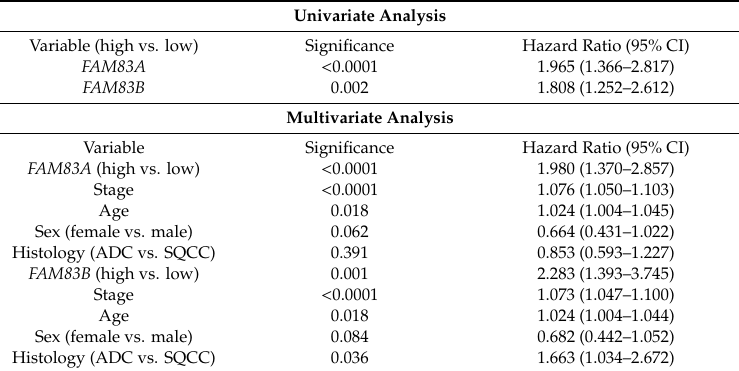
Table 3. Univariate and multivariate analysis of FAM83A and B